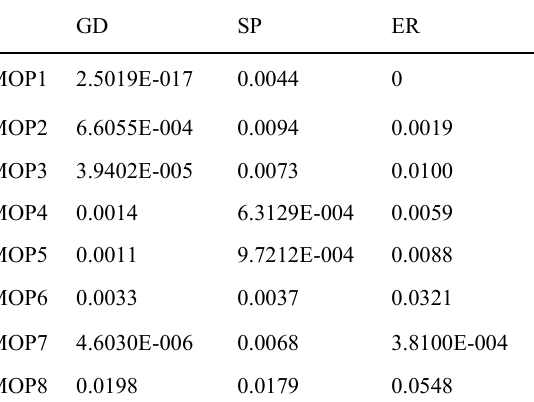
Fig.6. Pareto front of MOP6